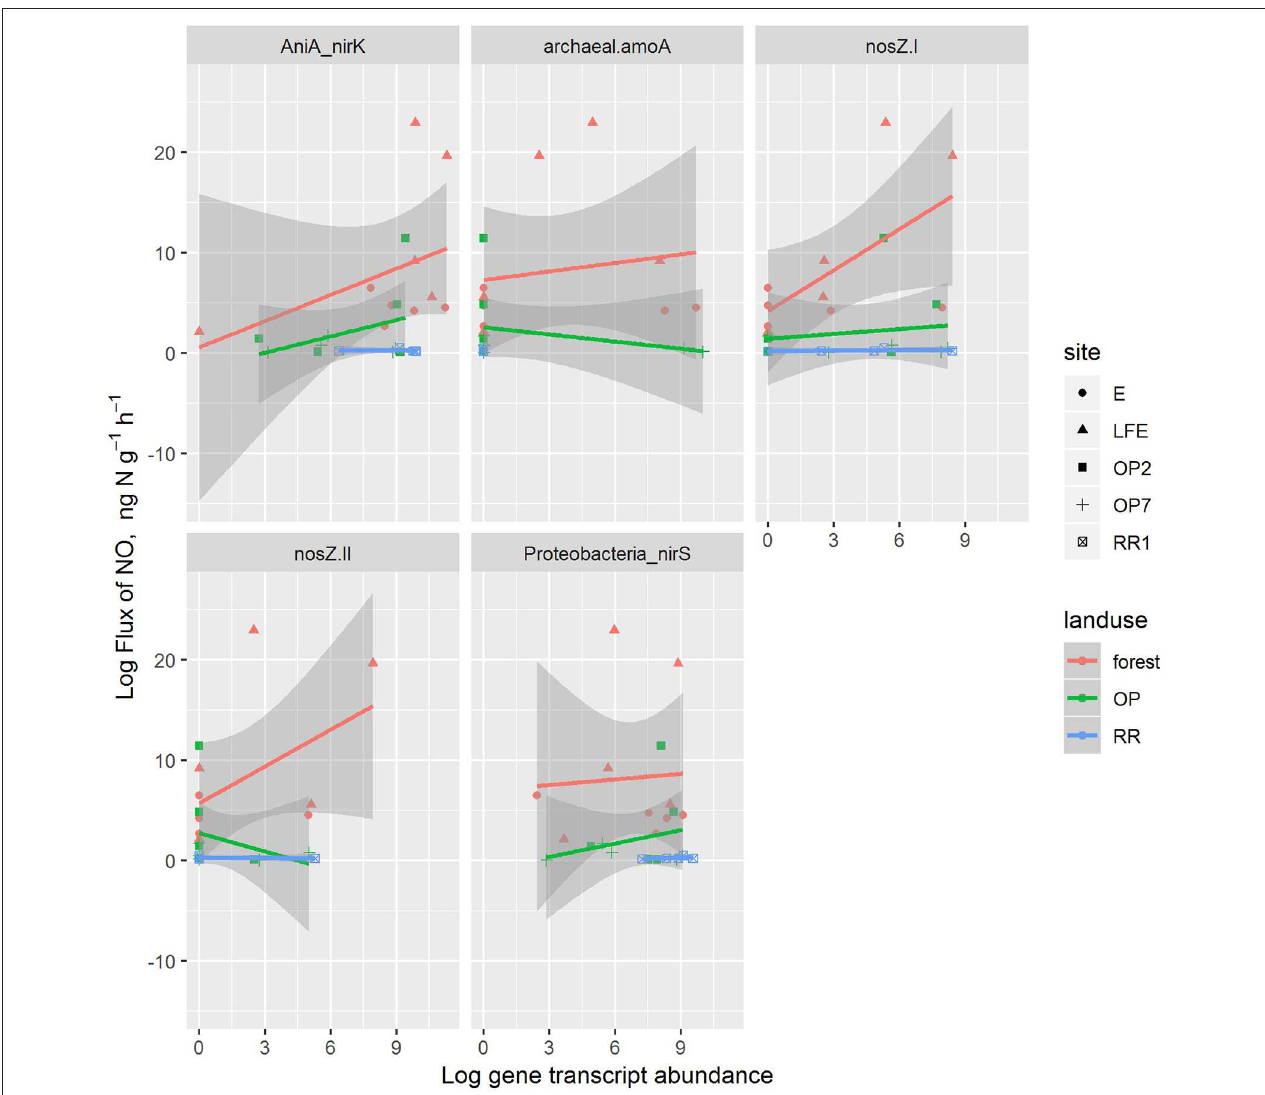
FIGURE 5 | The correlations between NO fluxes with and transcript abundances of denitrifier and nitrifier genes in different land-use soils [red: oil palm (OP), green: logged forest (forest), blue: riparian reserve (RR)]. For site identification, E and LFE are logged forest, OP2 and OP7 are oil palm plantations and RR1 is riparian soil.